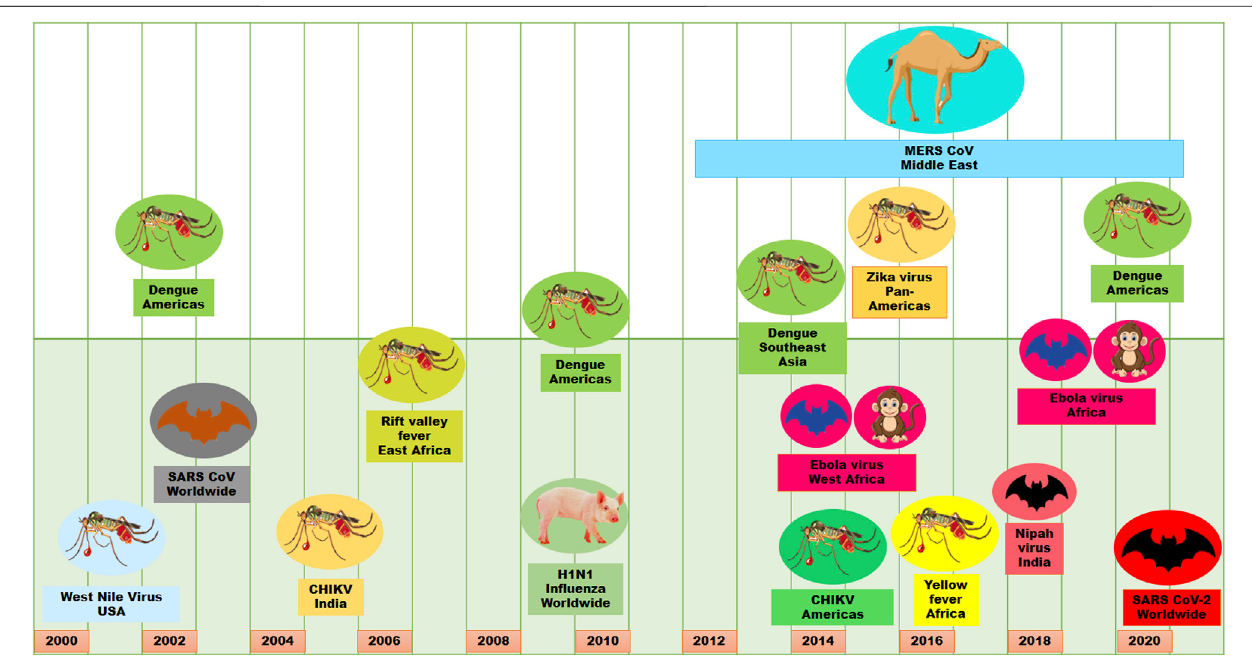
FIGURE 1 | Viral outbreaks in the last 2